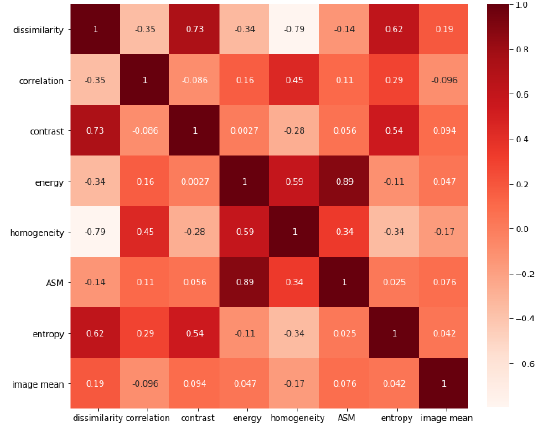
Figure 2. Correlations in the initial GLCM feature